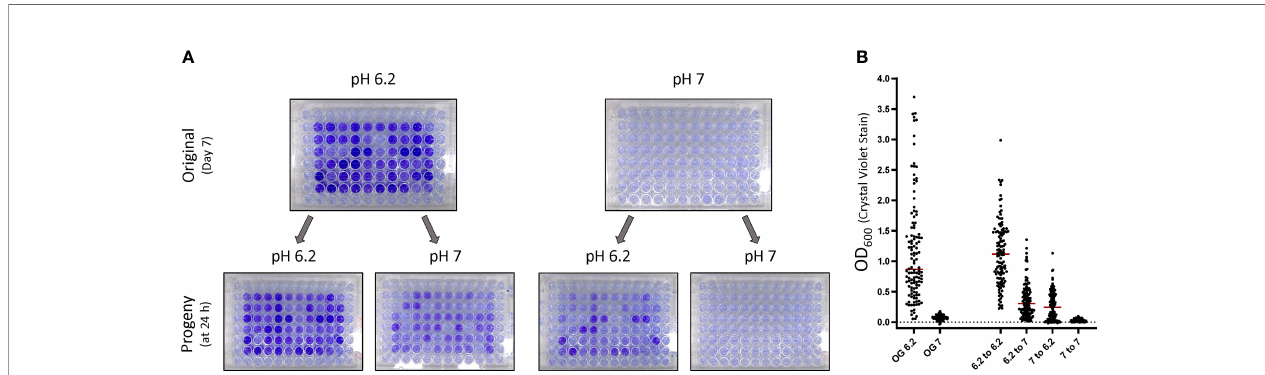
FIGURE 5 | pH acts as an environmental checkpoint for initiation of bio fi lm matrix assembly. LVS bio fi lms were grown in CDM adjusted to the indicated pH. After 7 days, bacteria were sub-cultured into either CDM at pH 6.2 or 7 and the progeny bio fi lms were stained at 24 h. (A) Representative images of bio fi lm plates crossed into CDM at each pH. (B) Graphed data after 3 independent experiments. Red bars indicates the median. OG indicates the original plates from which progeny plates were inoculated.